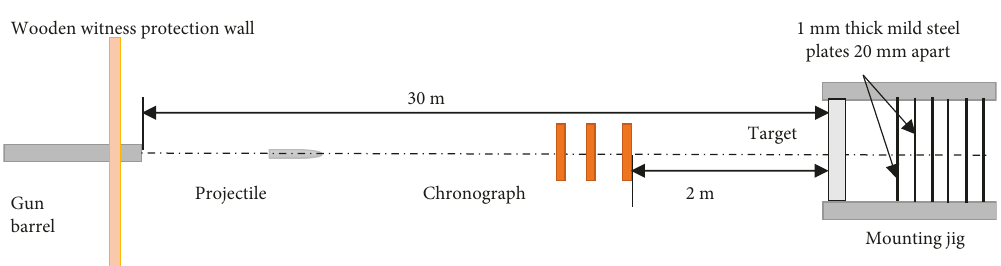
Wooden witness protection wall